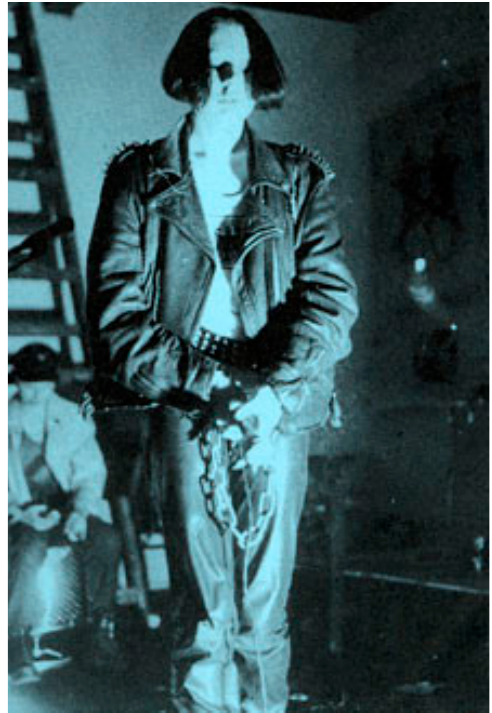
Figure 4. Fistfuck (Jill Westwood), Performance with chains and vocal , 21 June 1983, “The Equinox Event”, London Musician’s Co-Op, Camden, London.